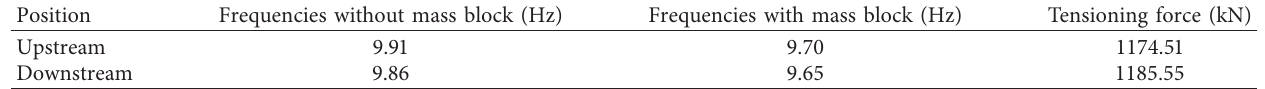
Table 2: Comparison results of cable forces.